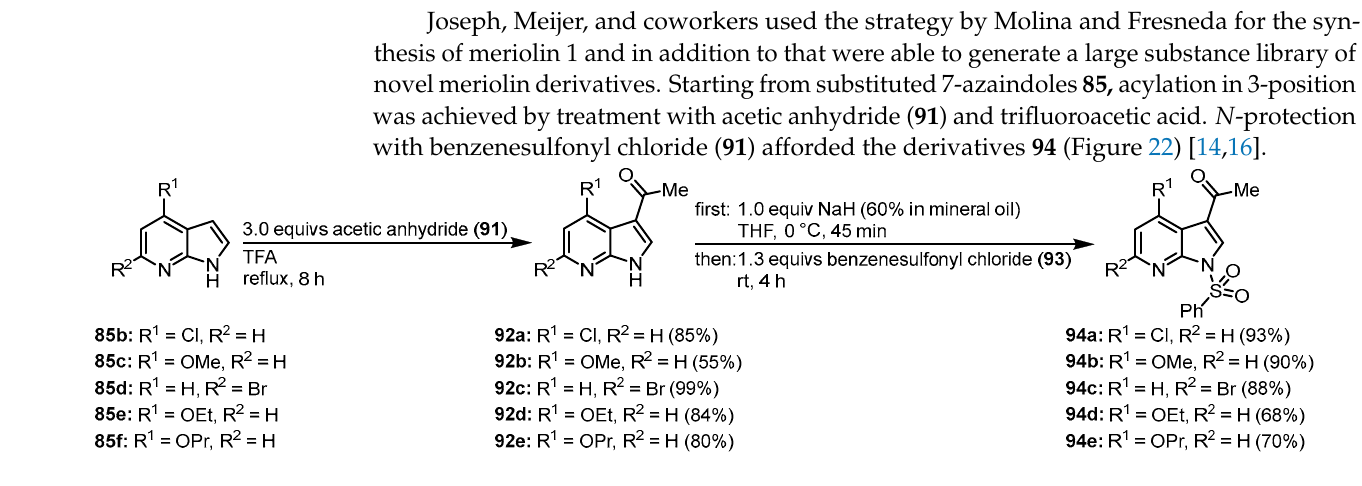
Figure 22. Preparation of 3-acetyl- N -protected intermediates 94 [14].